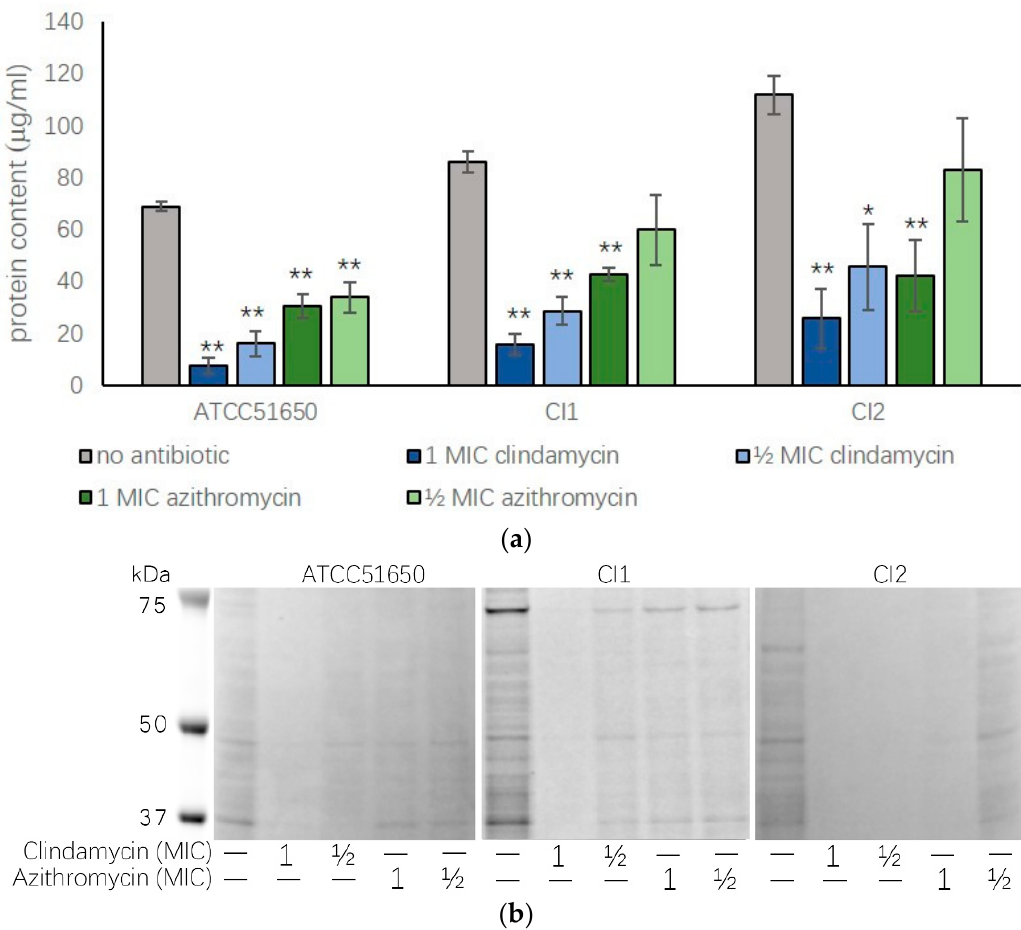
Figure 3. Biofilm protein content after ½ MIC and 1 MIC clindamycin and azithromycin treatment. ( a ) Protein content measured by NanoOrange ( µ g / mL) or ( b ) gel electrophoresis of 48-h biofilms of ATCC 51650, CI1 or CI2 in the absence (no antibiotic, grey bar) or presence of ½ MIC and 1 MIC clindamycin (blue bars) or azithromycin (green bars). (* p < 0.05, ** p < 0.01, one-way ANOVA followed LSD post hoc comparison, n = 3). Table 3. Gray scale analysis of the SDS-page of 48-h biofilms with Image J. (compared with no